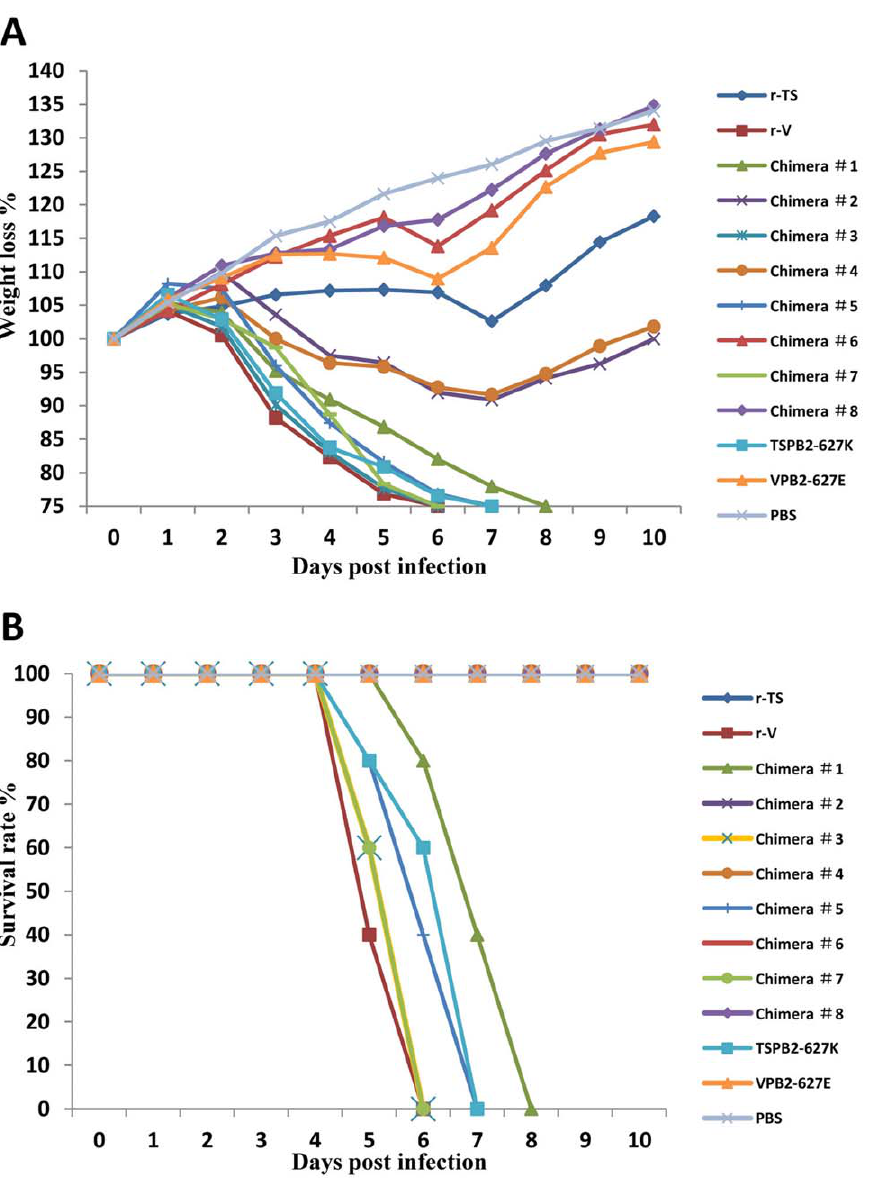
Figure 4. Weight changes and mortality of mice inoculated with parental, chimeric or mutated viruses. A) Weight changes; B) Mortality of mice inoculated with parental, chimeric or mutated